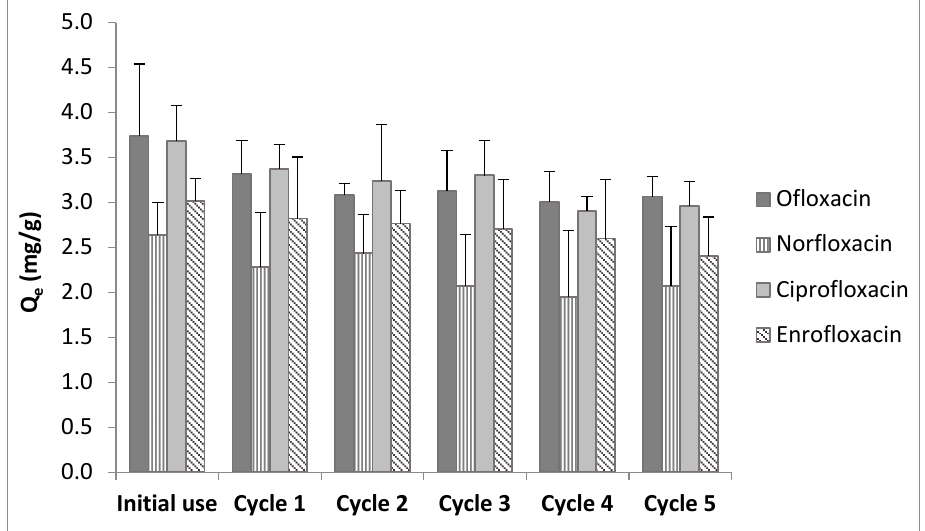
Figure 5. Results of reuse studies.